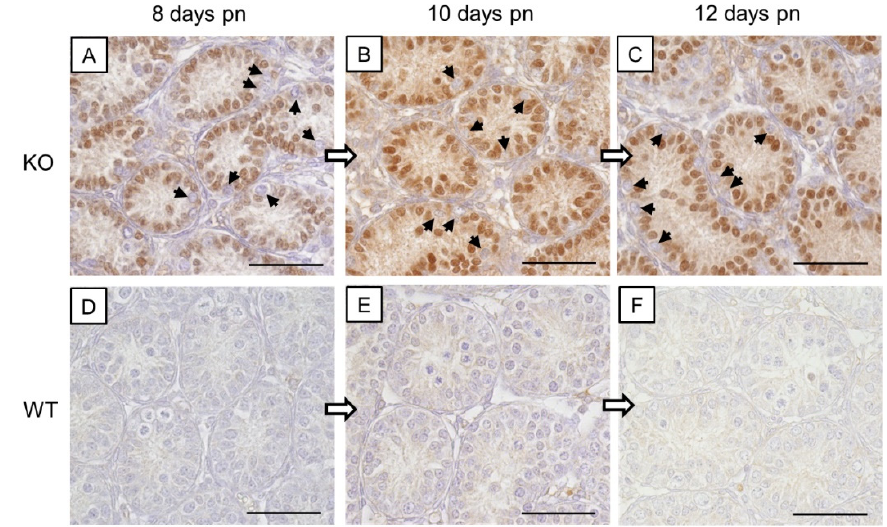
Figure 1. β -galactosidase immunohistochemistry. ( A – C ) Strong immunostaining of Sertoli cell nuclei in prepubertal SCCx43KO mice confirmed the successful deletion of the Cx43 gene. All other cells, including germ cells (arrows) were immunonegative. ( D – F ) No immunoreaction in Sertoli cells of